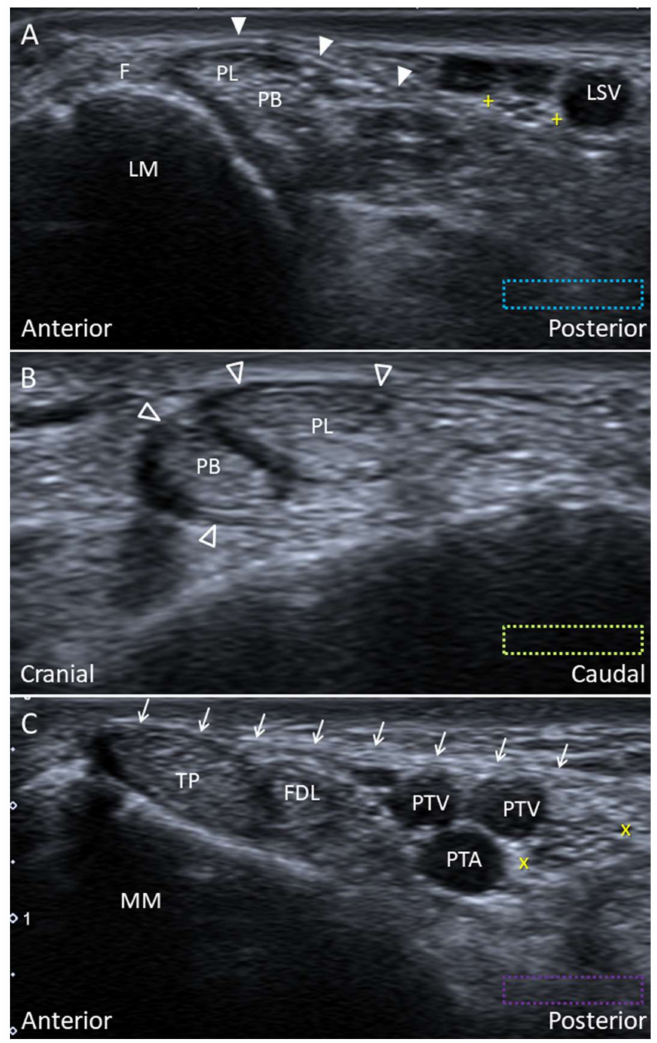
Figure 18. Imaging of the superior (arrowhead) ( A ) and inferior peroneal (void arrowheads) ( B ) retinacula and the flexor retinaculum (arrows) ( C ). The colored dashed rectangles are in accordance with the transducer positions in Figures 2A and 3A. “ + + ”: lateral sural nerve; “x x”: tibial nerve; F: fibrocartilage; FDL: flexor digitorum longus tendon; LM: lateral malleolus; LSV: lesser saphenous vein; MM: medial malleolus; PB: peroneus brevis tendon; PL: peroneus longus tendon; PTA: posterior tibial artery; PTV: posterior tibial vein; TP: tibialis posterior